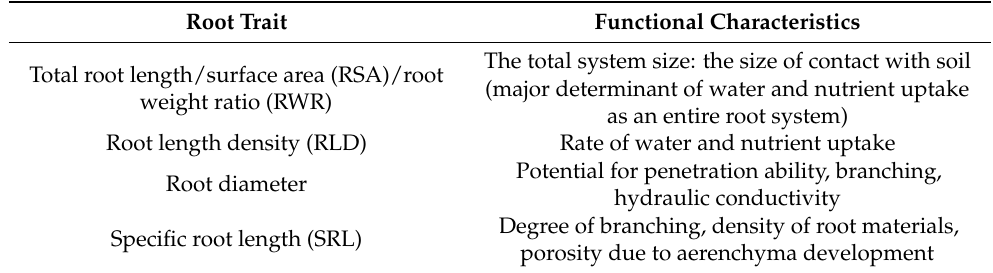
Table 2. Root traits and their functional characteristics. Root Trait Functional Characteristics The total system size: the size of contact with soil Total root length/surface area (RSA)/root (major determinant of water and nutrient uptake weight ratio (RWR) as an entire root system) Root length density (RLD) Rate of water and nutrient uptake Potential for penetration ability, branching, Root diameter hydraulic conductivity Degree of branching, density of root materials, Specific root length (SRL) porosity due to aerenchyma